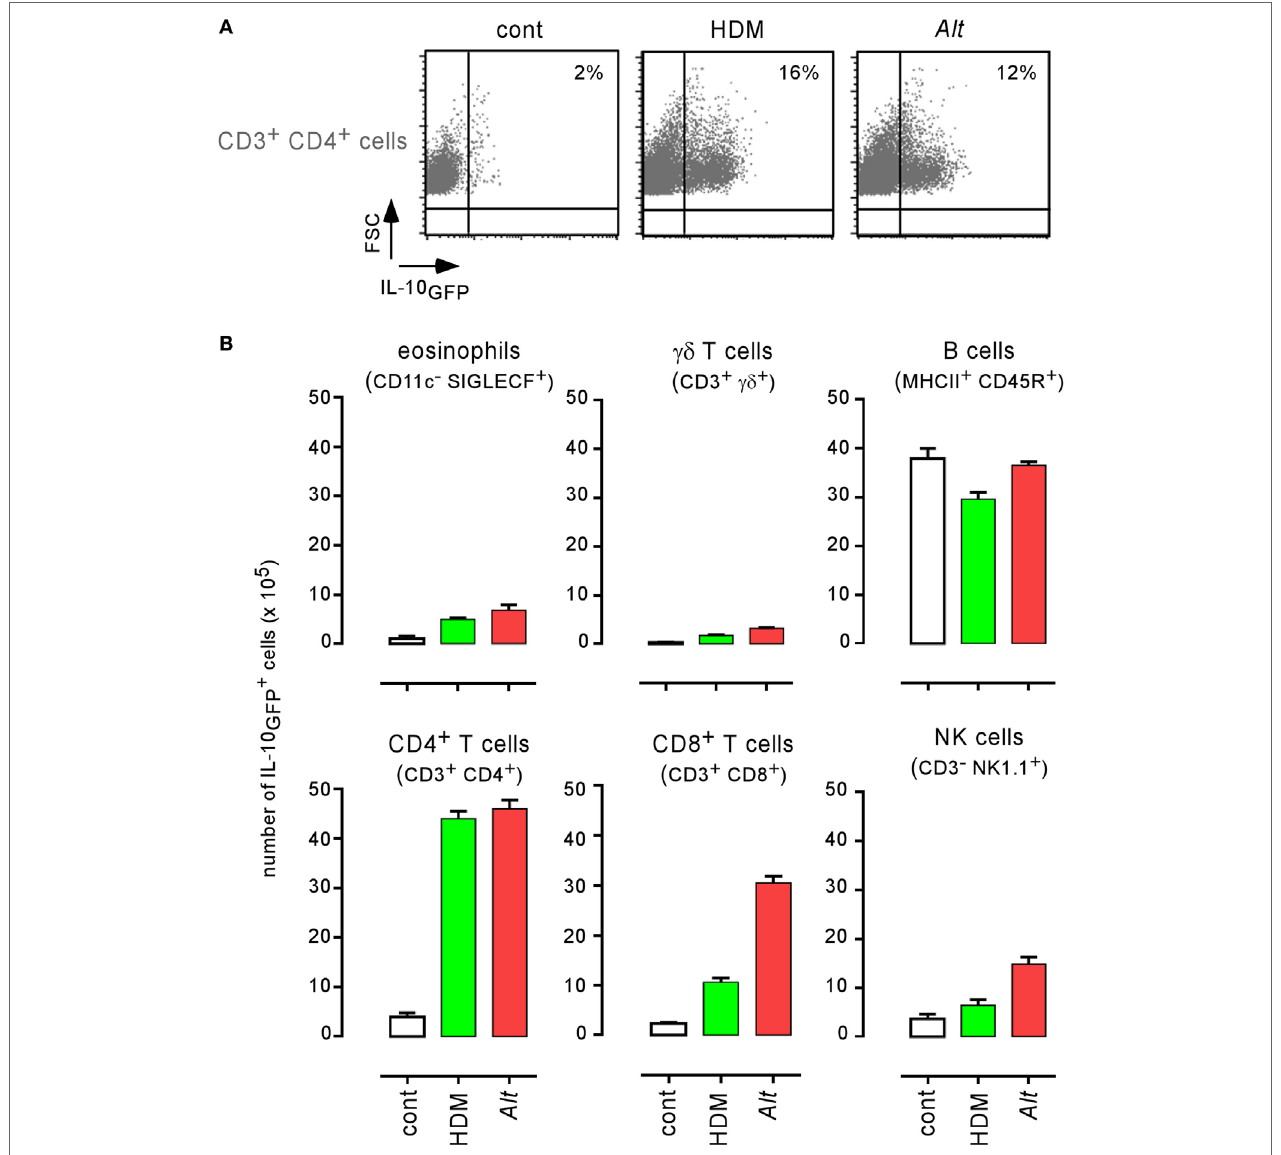
FigUre 9 | Characterization of IL-10 producing cells in lungs from infected asthmatic mice. IL-10 GFP transgenic C57BL/6 mice were sensitized with phosphate- buffered saline (PBS) (control group), HDM, or Alt before i.n. infection with 2 × 10 4 CFU of Brucella melitensis . The mice were sacrificed at 12 days post infection, and the spleen cells were analyzed by flow cytometry. (a) Cells from PBS, HDM, and Alt infected mice were analyzed for IL-10GFP, CD3, and CD4 expression. The figure shows representative dot plots from individual lungs in each group, as indicated in the figure. Numbers represent the percentage of IL-10GFP + cells in 50,000 acquired events. (B) The data represent the number of IL-10GFP + eosinophils, γδ + T cells, B cells, CD4 + T cells, CD8 + T cells, and natural killer cells per 10 5 lung cells from control, HDM, and Alt infected mice. The data are representative of two independent